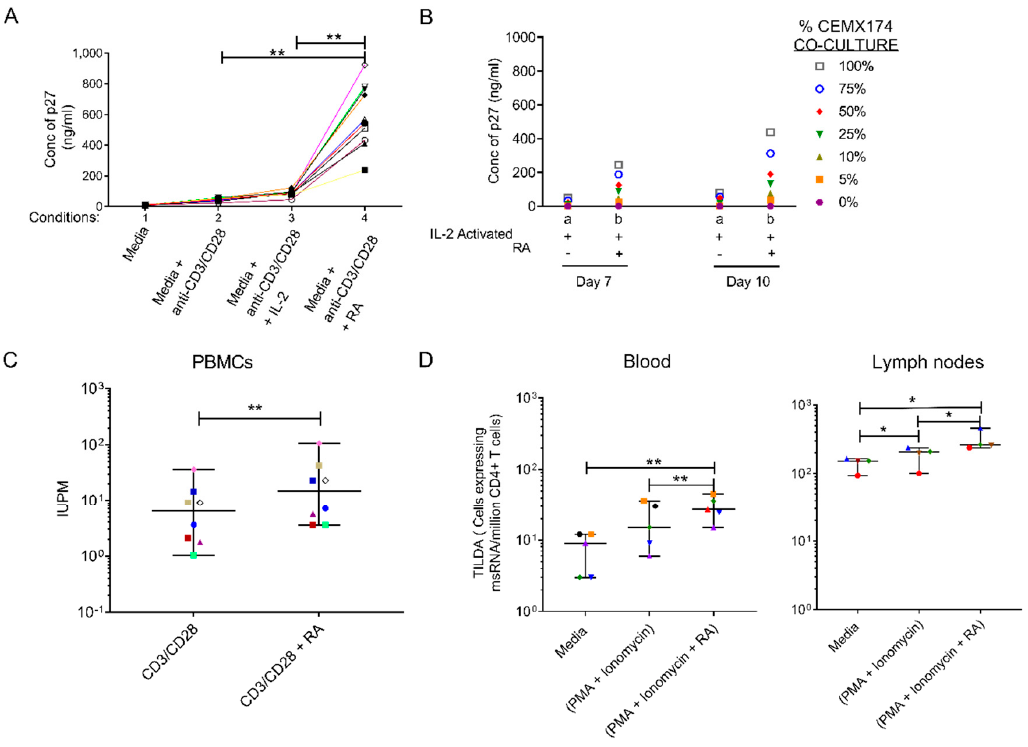
Figure 1. Retinoic Acid (RA) enhances viral replication in vitro and improves detection of the viral reservoir. ( A ) P27 levels were measured in supernatant of 10 randomly selected naive Peripheral blood mononuclear cells (PBMCs) infected with SIVmac239 after in vitro culturing with (1) media, unstimulated (2) anti-CD3/CD28 beads to activate the T-cell receptor (3) anti-CD3/CD28 + IL-2 and 4) anti-CD3/CD28 beads + IL-2 together with RA added under separate conditions on day 10. ( B ) Levels of p27 detected in supernatant fluids from pooled ( n = 10 RMs) enriched CD4 T cells that were treated with either (a) anti-CD3/CD28 and IL-2 only or (b) anti-CD3/CD28 + IL-2 and RA. Thereafter, viral expansion was carried out by the co-culture with CEMX174 cells across different concentrations (0 to 100%) on days 7 and 10 respectively. ( C ) Quantitative Viral Outgrowth Assay (QVOA) of CD4 + T cells purified from PBMCs of anti-retroviral therapy (ART)-suppressed macaques indicating levels of Infectious Units per Million (IUPM) in CD3/CD28 versus CD3/CD28 + RA conditions ( n = 8). ( D ) levels of msRNA transcripts obtained from enriched CD4 T cells collected from PBMC ( n = 5 RMs) or auxiliary lymph node CD4 + T cells ( n = 4 RMs) that were cultured in media only, media plus phorbol myristate acetate (PMA) + ionomycin and media plus PMA + ionomycin supplemented with retinoic acid. * shows p < 0.05 and ** represents p < 0.001 significant difference across studied groups obtained using Wilcoxon matched pairs signed rank tests.